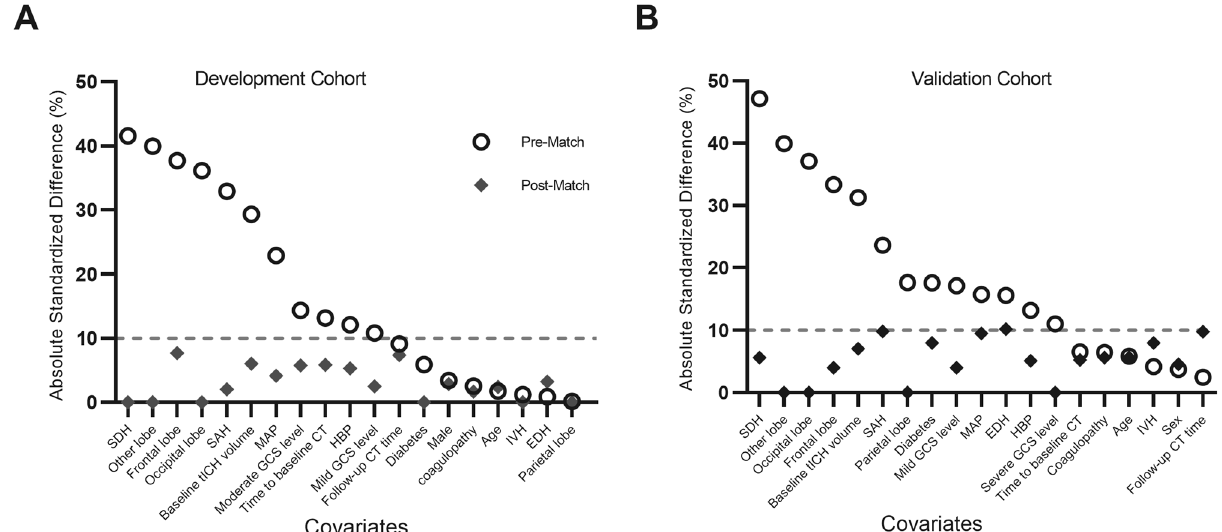
Figure 3. Absolute standardized differences before and after propensity score matching comparing variables values for patients with and without the multihematoma fuzzy sign in the development ( A ) and external validation cohorts ( B ).